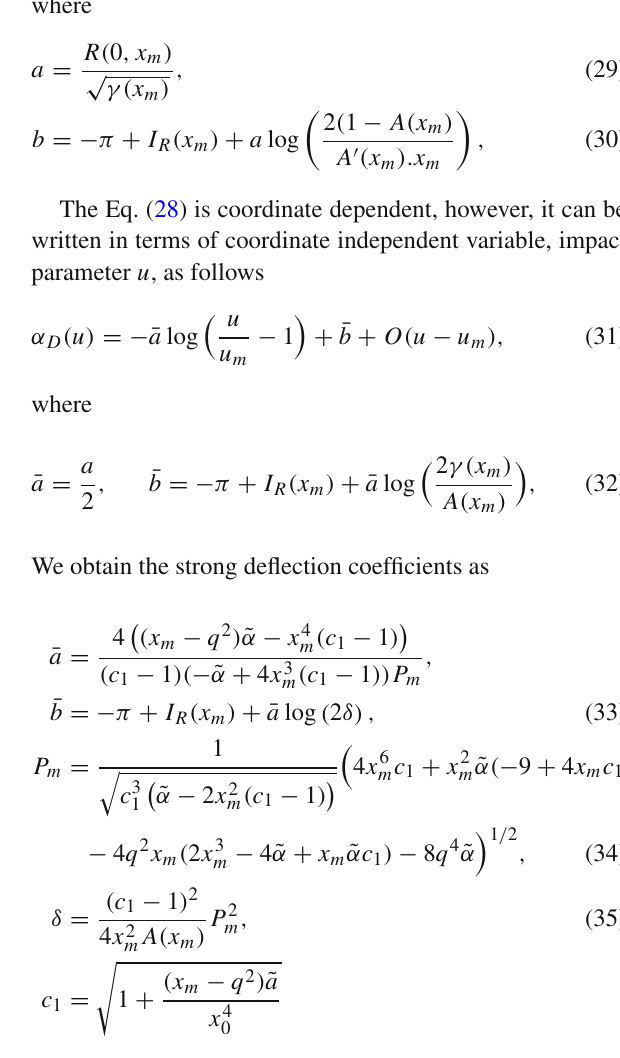
¯ b are called the strong deflection limit coeffi- where ¯ a and cients. In Fig. 5, we plotted the impact parameter u m for the photons moving on the unstable circular orbits around black hole as a functions of charge parameter q and GB coupling parameter ˜ α . It is clear that u m decrease with q and ˜ α . The behavior of lensing coefficients are shown in Fig. 6, which in the limits of ˜ α → 0 and q = 0, smoothly retain the values for ¯ b = − 0 . 4002 the Schwarzschild black hole, viz., ¯ a = 1 and ¯ b decreases with [16,17]. Coefficient ¯ a increases whereas increasing q or α . The resulting deflection angle α D ( u ) is shown as a function of impact parameter u for various values of q and ˜ α in Fig. 7. For a fixed value of u , deflection angle decreases with increasing q or ˜ α , therefore, the deflection angle is higher for Schwarzschild and Reissner–Nordstrom blackholesthanthosefortheChargedblackholesof4 D EGB gravity. Figure 7 infers that the α D ( u ) increases as impact parameter u approaches the u m and becomes unboundedly large for u = u m